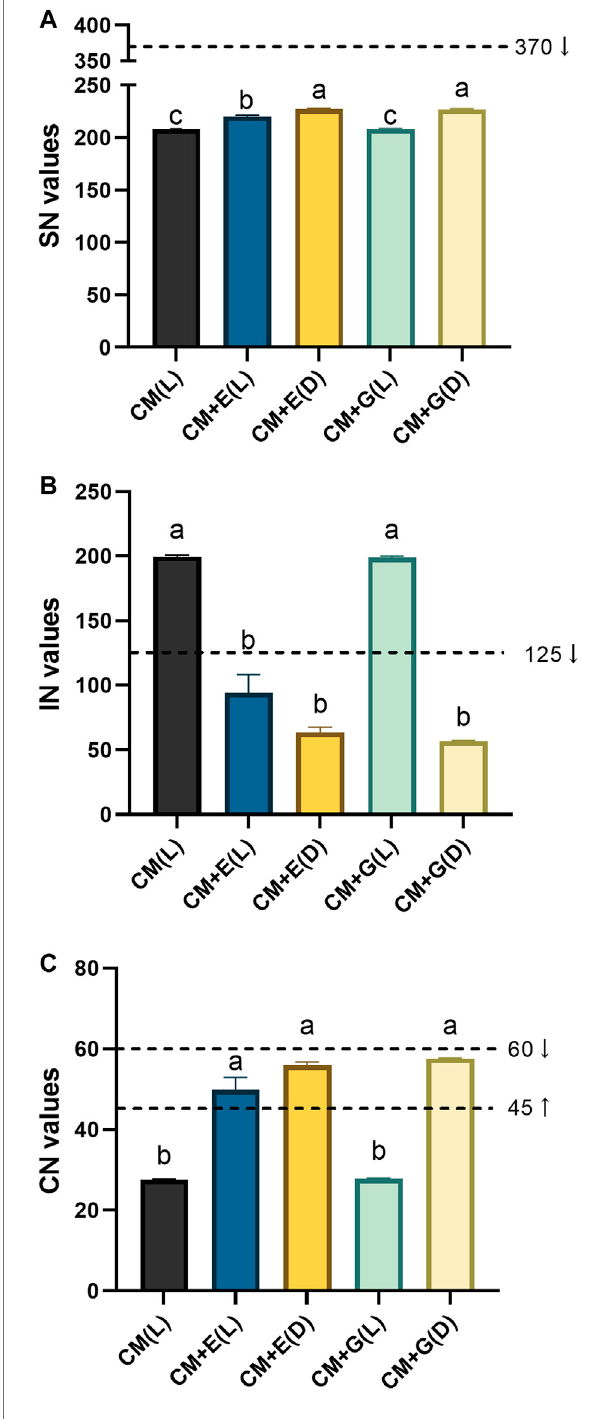
FIGURE 7 | Quality evaluation of biodiesel from E. gracilis 815 cultured under different conditions on Day 6. (A) SN values; (B) IN values; (C) CN values.Differentlettersindicatesigni fi cantdifferenceaccordingtoANOVAtest at p ≤ 0.05.Arrowsindicatetherequiredrangesofthesevaluesinseveral